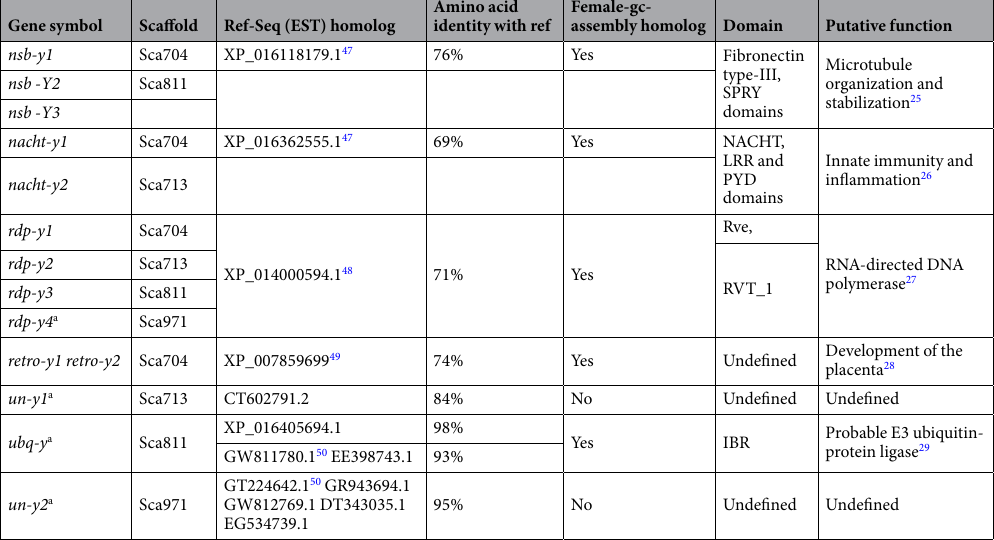
Table 4. Y-linked gene annotation. Notes: In the cases where the homolog is an annotated gene, we used the homolog gene name as an identifier, otherwise we used the “ un-y ” as an identifier. Amino acid identity with ref were computed by comparing sequences directly. a Genes in bold were selected for RT-PCR experiments, as shown in Fig.